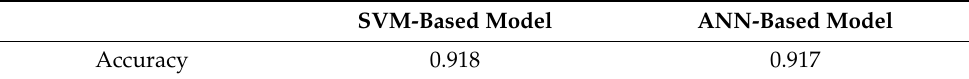
Table 5. Comparison between the accuracy returned by the SVM-based model and the ANN- based